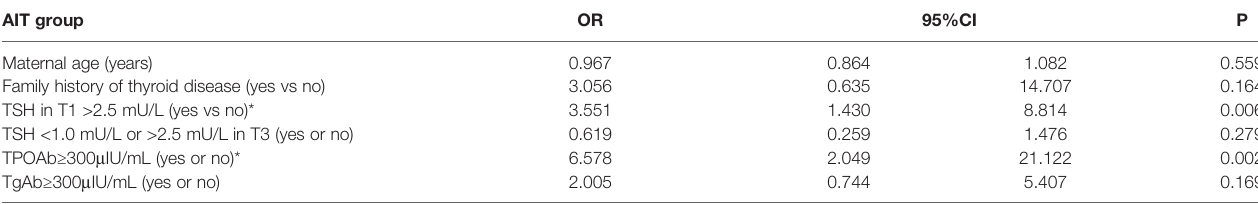
TABLE 3 | Logistic regression model for the risk factors of developing PPT in women with previously known hypothyroidism caused by AIT (n = 101). AIT group OR P Maternal age (years)